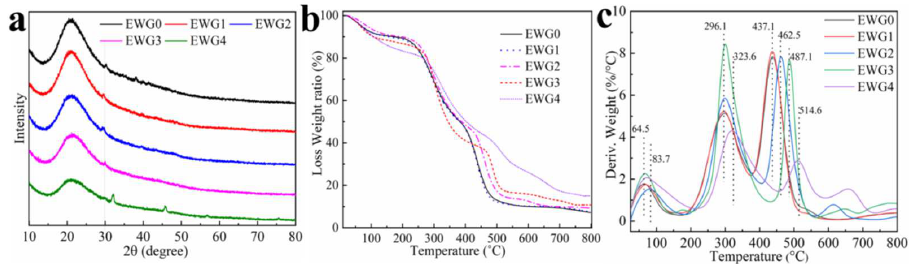
Figure 2. XRD patterns ( a ), TG curves ( b ) and DTG patterns ( c ) of hydrogels.